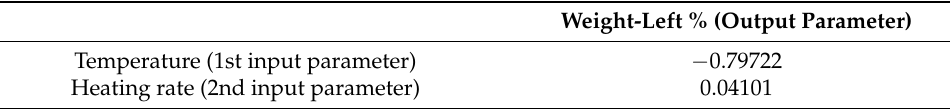
Figure 7. Error histogram of simulated data for ANN model.